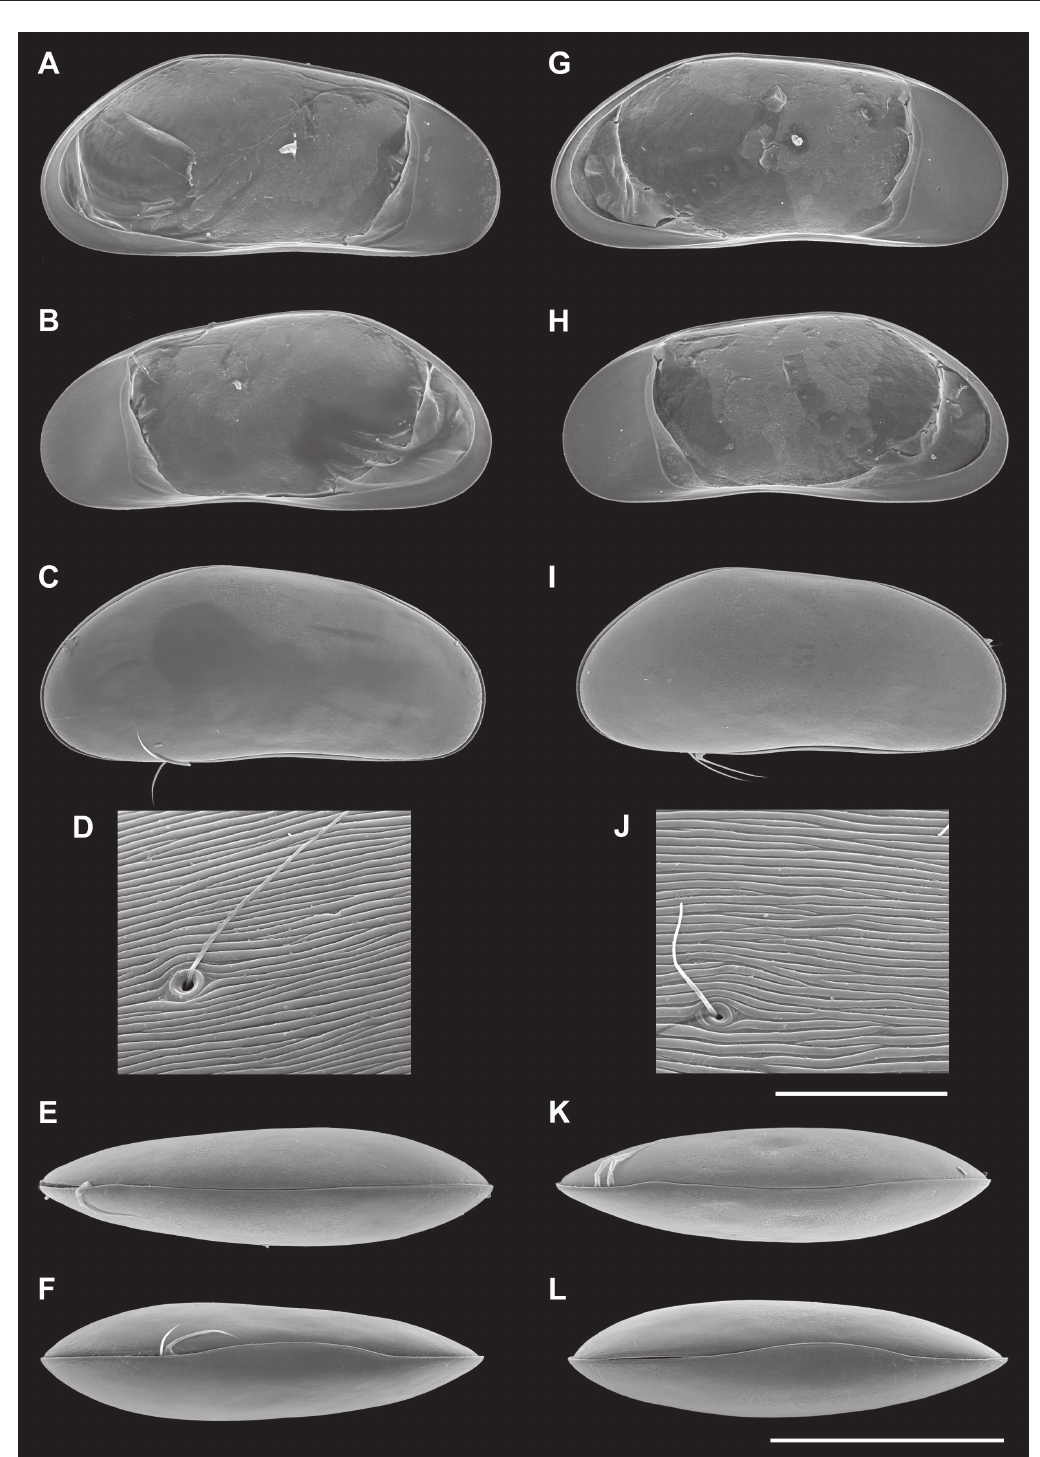
Fig. 10. Valves of Candobrasilopsis elongata sp. nov. A–F ♂ and G–L ♀. A, G . LV, internal view (A = MZUSP 32687, G = MZUSP 32686). B, H . RV, internal view (B = MZUSP 32687, H = MZUSP 32686). C, I . Cp, right lateral view (C = MZUSP 32690, I = MZUSP 32699). D, J . Cp, right lateral view detail (D = MZUSP 32690, J = MZUSP 32699). E, K . Cp, dorsal view (E = MZUSP 32692, K = MZUSP 32696). F, L . Cp, ventral view (F = MZUSP 32691, L = MZUSP 32697). Scale bars: A–C, E–I, K–L = 500 µ m; D, J = 20 µ